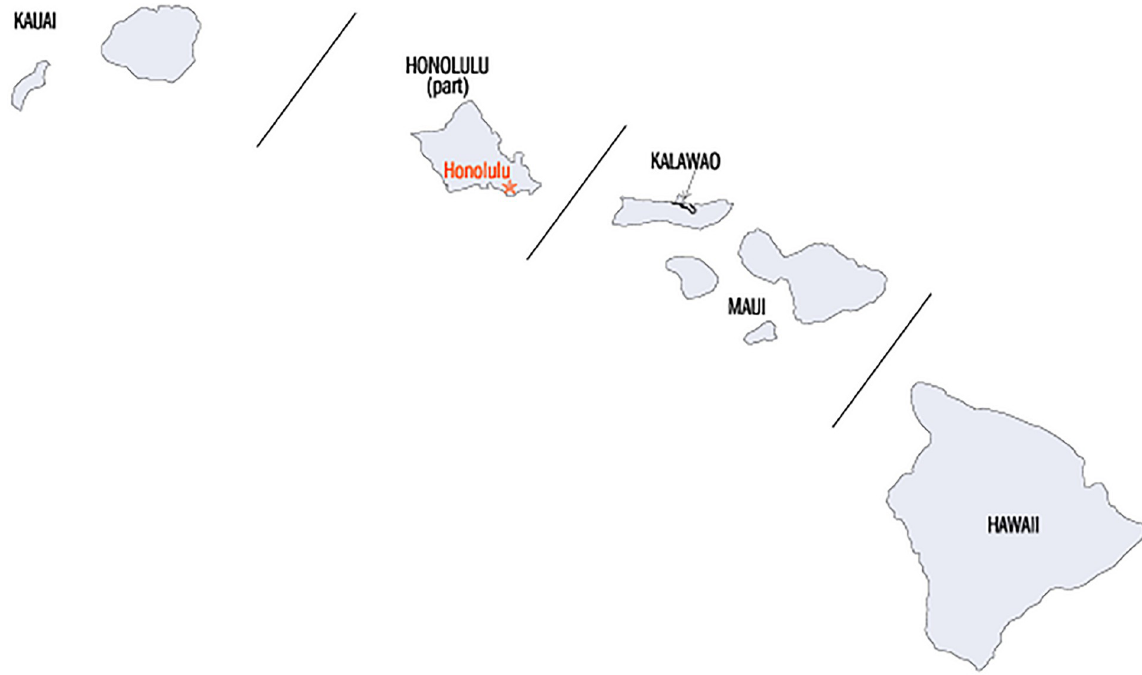
Fig 1. The state of Hawai‘i and its counties. Kaua‘i county encompasses the islands of Kaua‘i and Ni’ihau. Honolulu county contains only the island of Oahu. Maui county comprises the islands of Maui, Moloka’i, Lana’i, and Kaho’olawe. Hawai‘i county contains only the island of Hawai‘i. Taken from Maps of World, Countries &